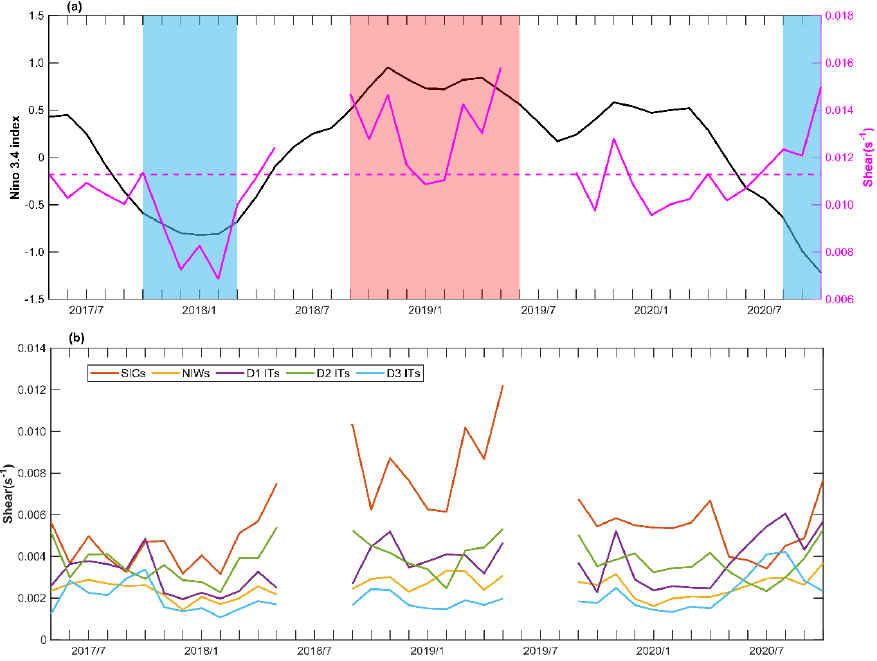
Figure 17. ( a ) Time series of the monthly 3-month running-averaged Niño 3.4 index (black solid line) and the total shear averaged above 100 m (magenta solid line); the light-red and light-blue shadings denote the El Niño event and La Niña event, respectively. The magenta dashed line indicates the mean total shear averaged above 100 m. ( b ) Time series of the monthly shear caused by SICs, NIWs, and ITs averaged above 100 m.